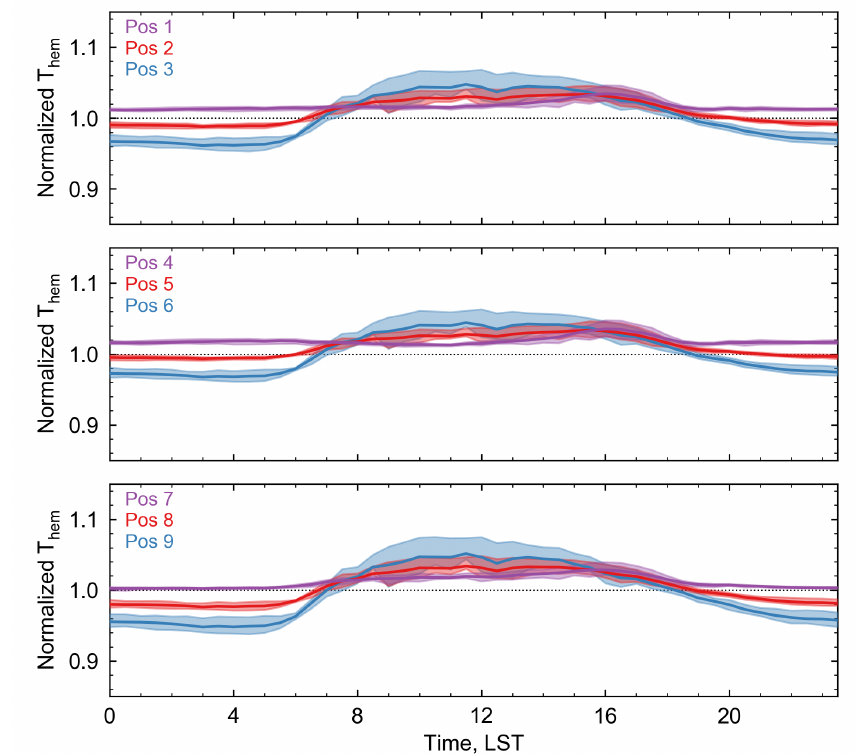
Figure A4. Mean T hem, r normalized against T comp for each sensor position over the 14-day subset of the IOP for a sensor height of three times mean building height. Shaded area indicates quartiles